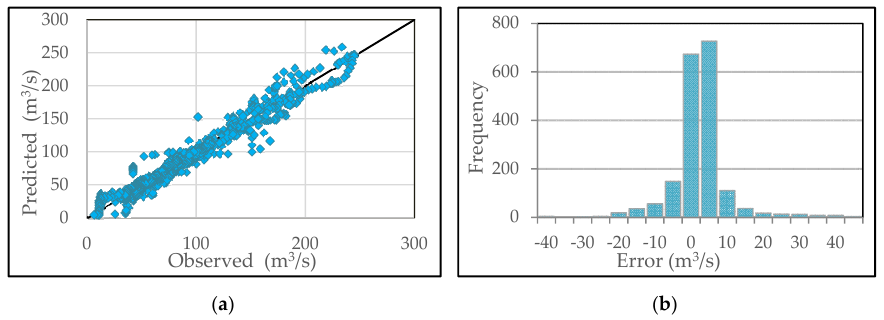
Figure 10. (a) Flow forecasts vs measured flows at the Graus station (left). (b) Empirical frequency distribution of the errors (calibration data set) (right).